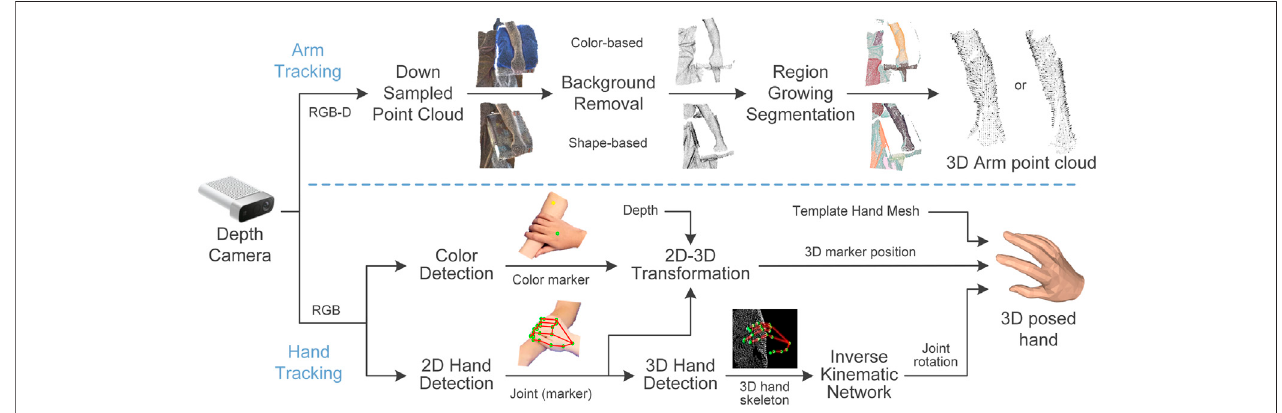
FIGURE 1 | 3D visual tracking setup and data work fl ow. The toucher ’ s hand and receiver ’ s forearm are tracked using one depth camera (Microsoft Azure Kinect). Forearm shape is extracted as a point cloud while the hand mesh is animated by the gestures and movements of the toucher ’ s hand.